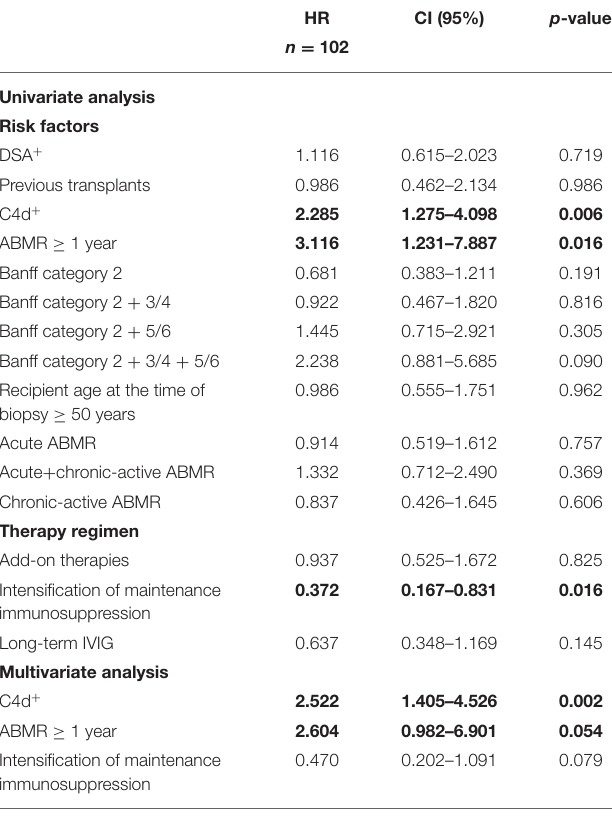
TABLE 3 | Results of univariate and multivariate analyses identifying risk factors and protective factors for allograft failure among 102 renal allograft recipients with ABMR.